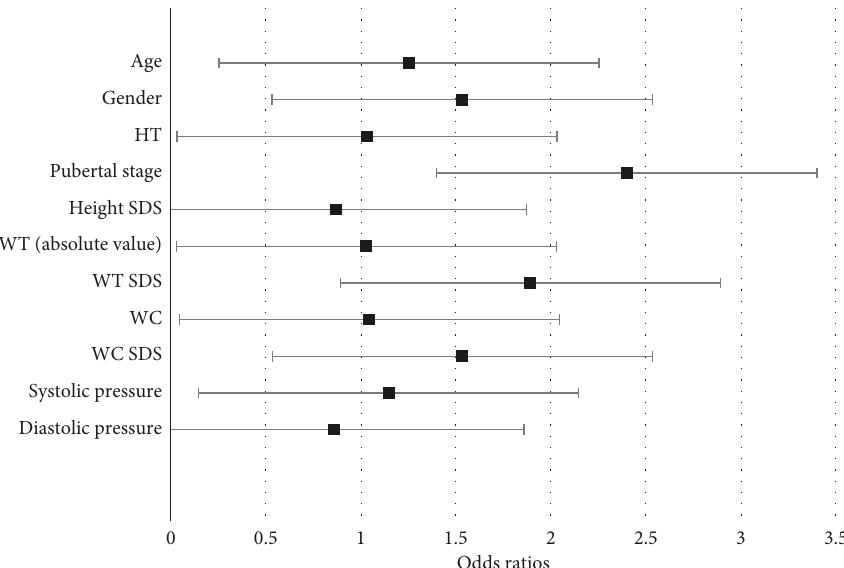
Figure 3: Bivariate logistic regressions between predictor variables and having fatty liver